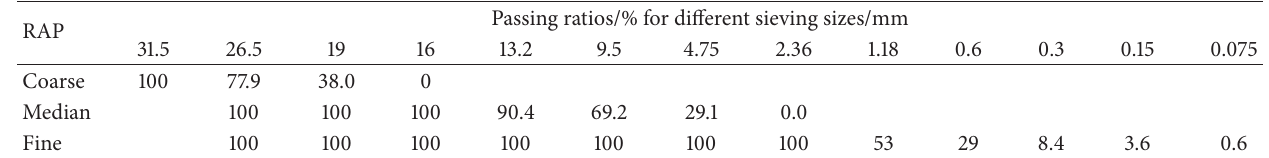
Table 1: Gradations for coarse, median, and fine RAP.